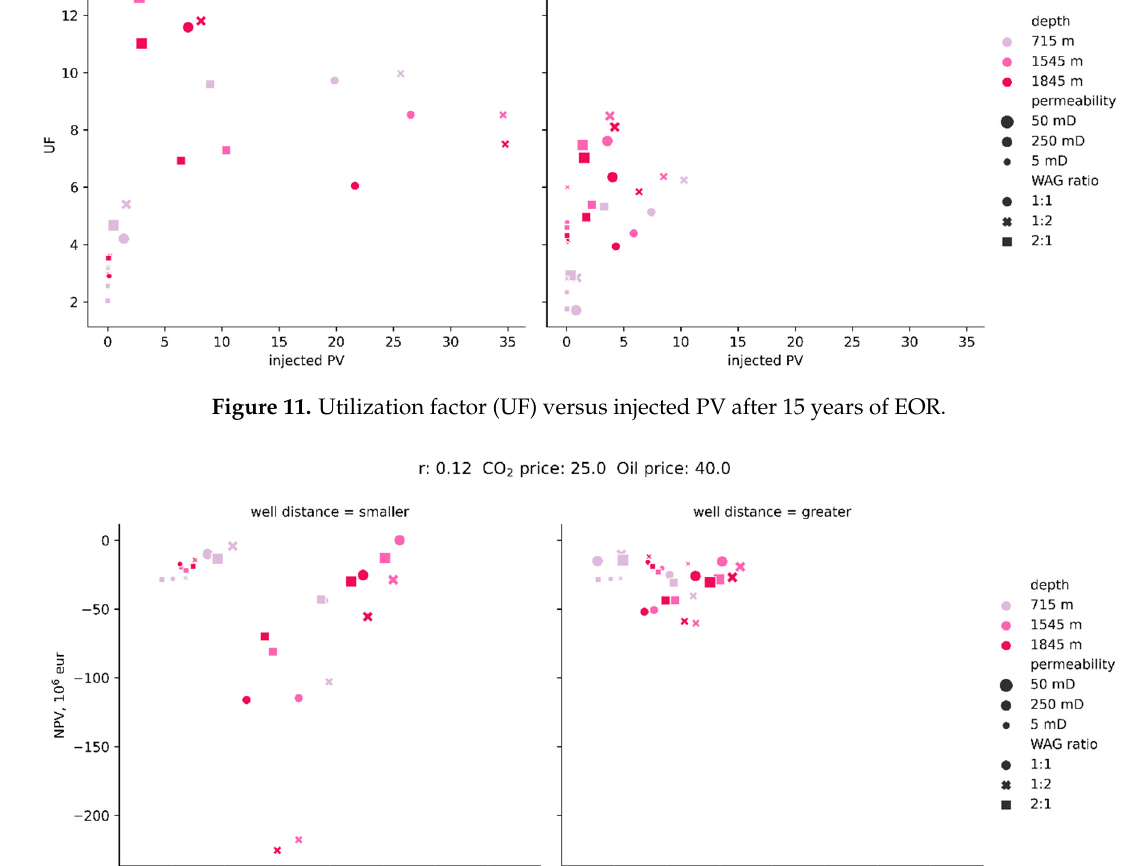
Figure 11. Utilization factor (UF) versus injected PV after 15 years of EOR.